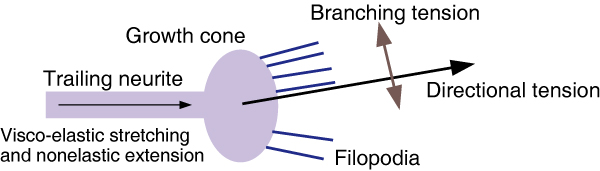
Axonal pathfinding. Detection of chemoattractants in the external environment by filopodia produces tension on the growth cone in particular directions. The growth cone will turn towards and grow along the dominant direction. If similar forces are exerted on opposite sides of the cone, the tension may be enough to split the cone into two, leading to the formation of daughter branches.